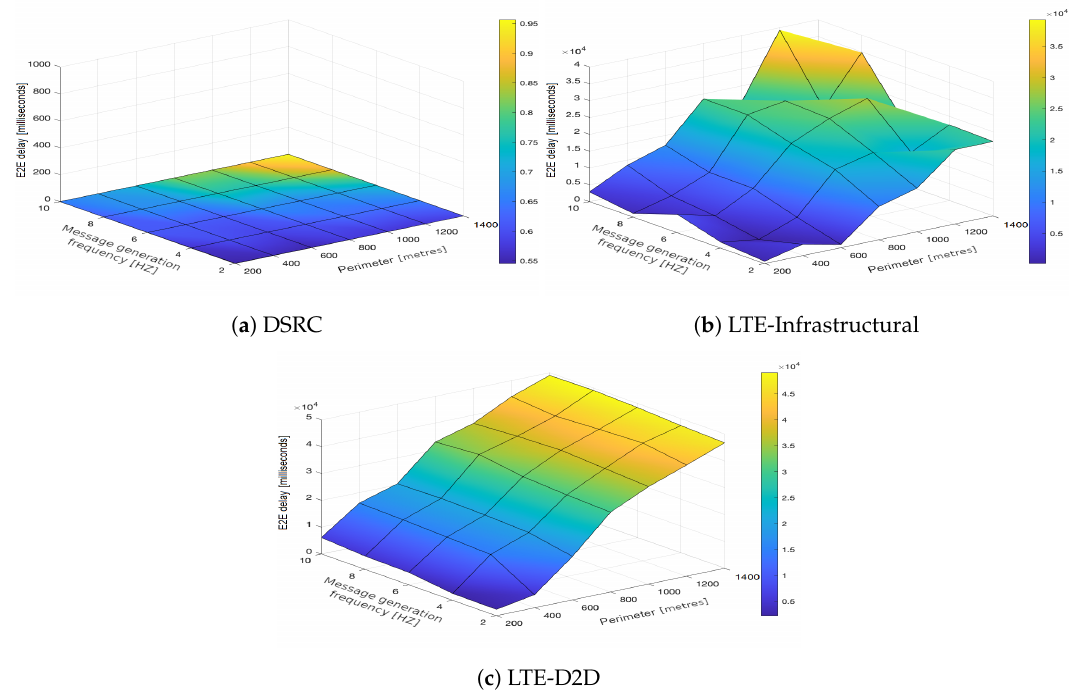
Figure 12. End-to-end delay obtained for the traffic intensity of 1250 vehicles per